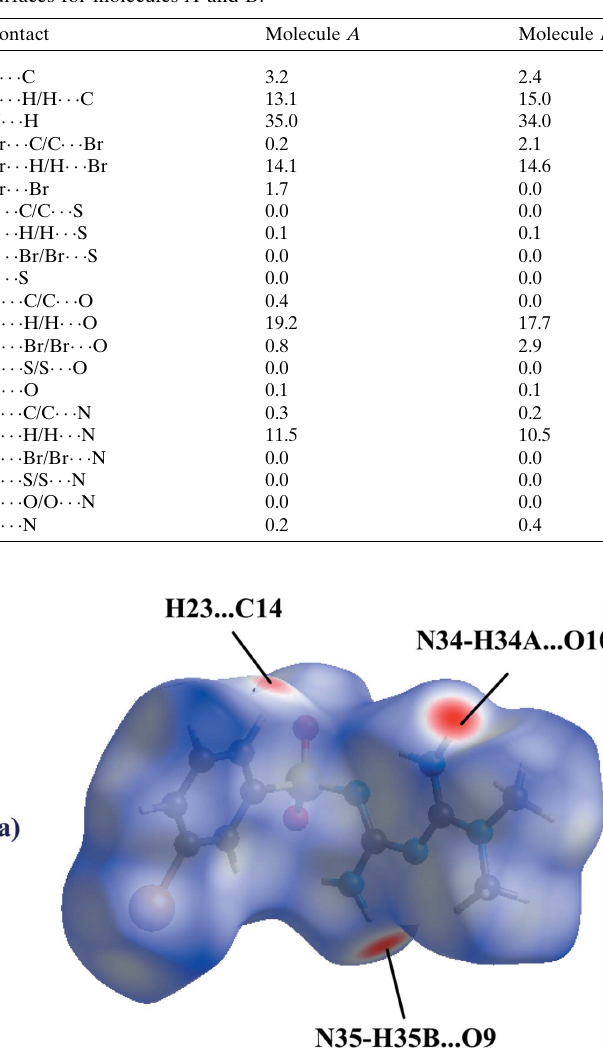
Table 2 Percentage contributions of interatomic contacts to the Hirshfeld surfaces for molecules A and B